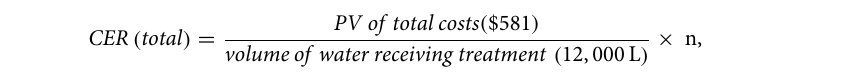
Figure 3. Response surface graphs for hydrocarbon reduction, COD reduction, and increase in plant